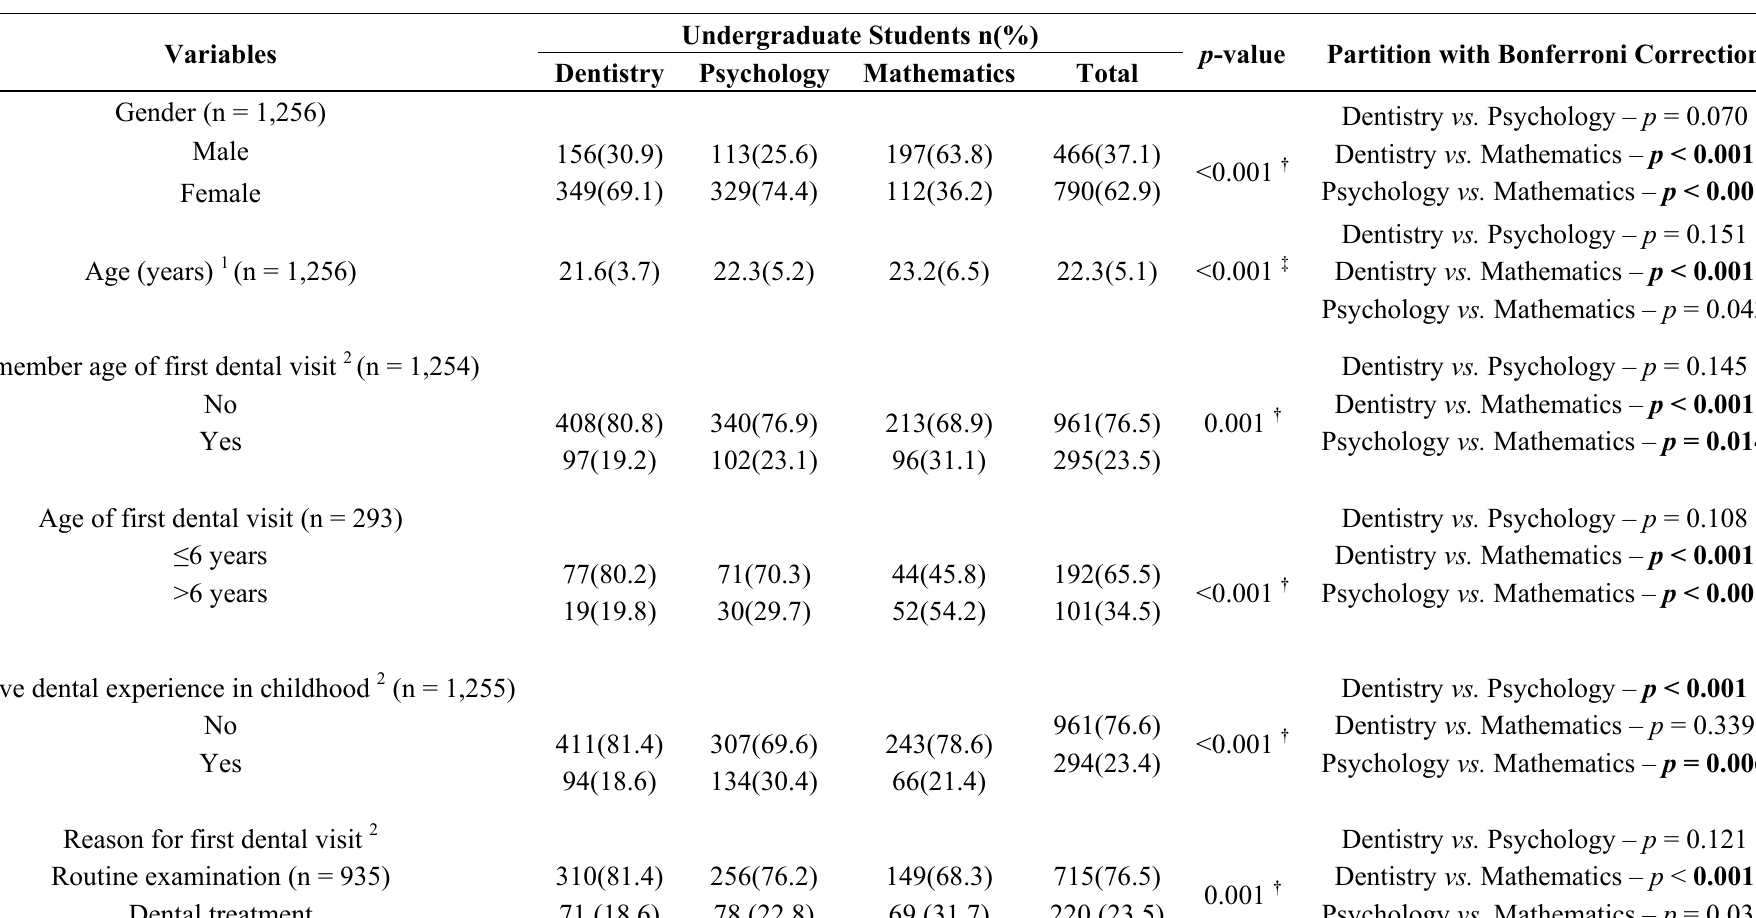
Table 1. Frequency distribution and association of undergraduate students according to other independent